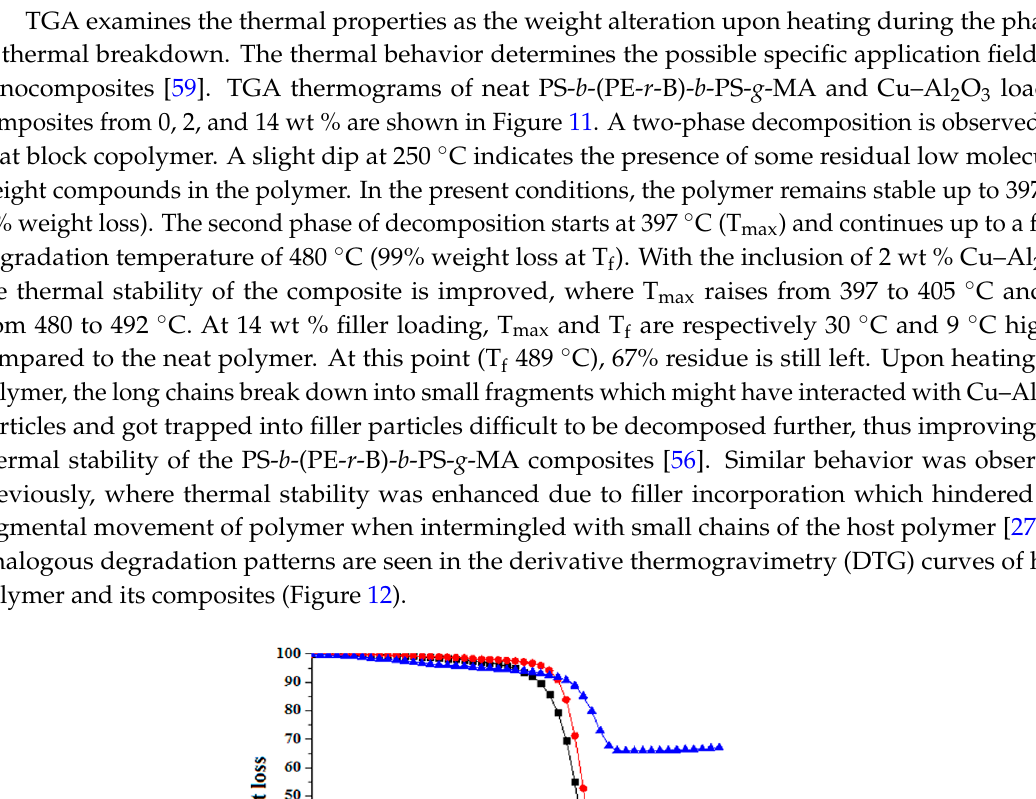
Figure 10. Elongation at break of Cu–Al 2 O 3 /PS- b -(PE- r -B)- b -PS- g -MA composites.